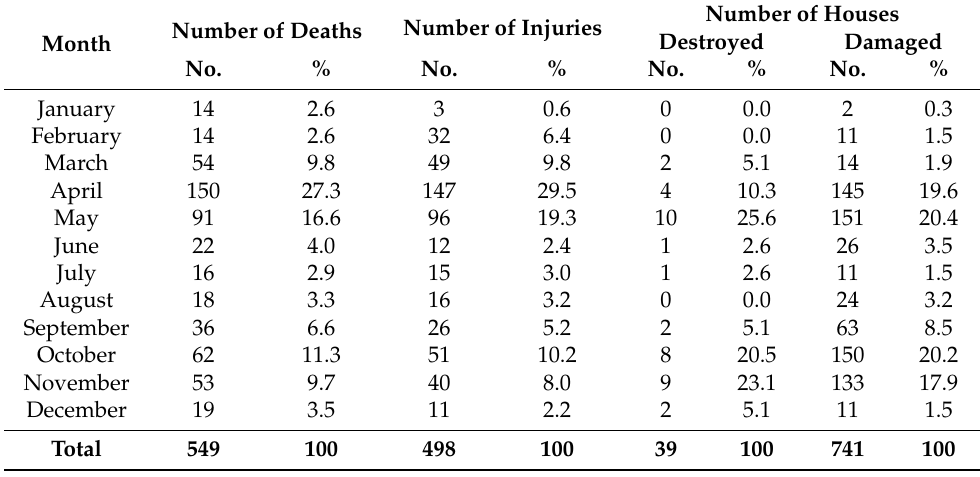
Table 2. Monthly variations of lightning accidents in Sri Lanka, from 1974 to